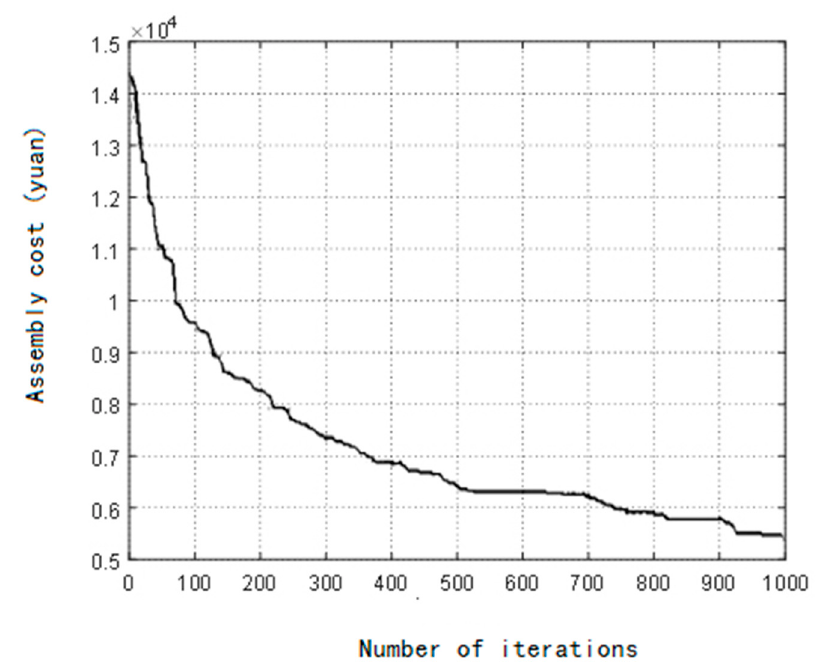
Figure 5. The calculation optimization diagram of the particle swarm genetic combination algorithm for classification selection.